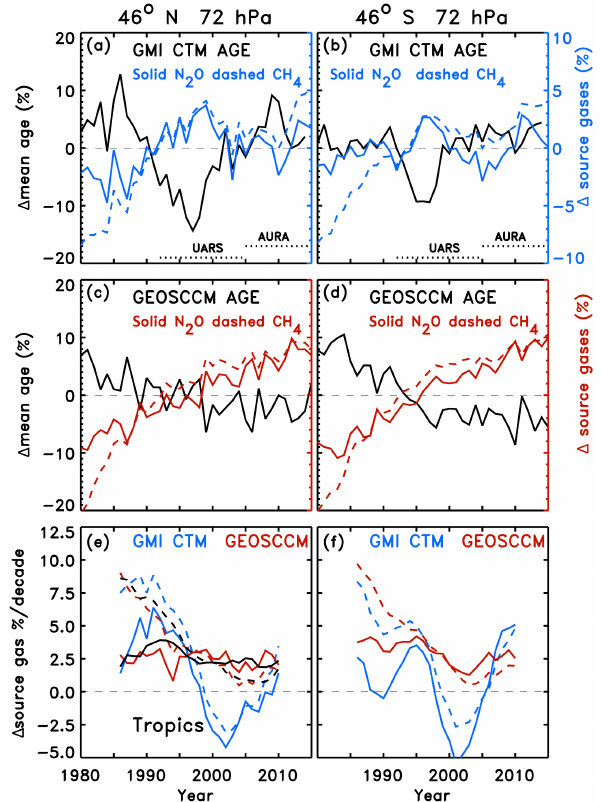
Figure 1. The GMI CTM differences from the 1980–2015 mean for mean age (black), N 2 O (blue) and CH 4 (blue dashed) at 72hPa for (a) 46 ◦ N and (b) 46 ◦ S. The GEOSCCM differences from the 1980–2015 mean for mean age (black), N 2 O (red) and CH 4 (red dashed) at 72hPa for (c) 46 ◦ N and (d) 46 ◦ S. Trends calculated for successive 10-year periods at 72hPa are shown for N 2 O (blue, GMI CTM; red, GEOSCCM) and CH 4 (blue dashed, GMI CTM; red dashed, GEOSCCM) at (e) 46 ◦ N and (f) 46 ◦ S. Tropical trends at 100hPa (black, N 2 O; black dashed, CH 4 ) are shown in ( e ). They are the same for both simulations and reflect the boundary condi-